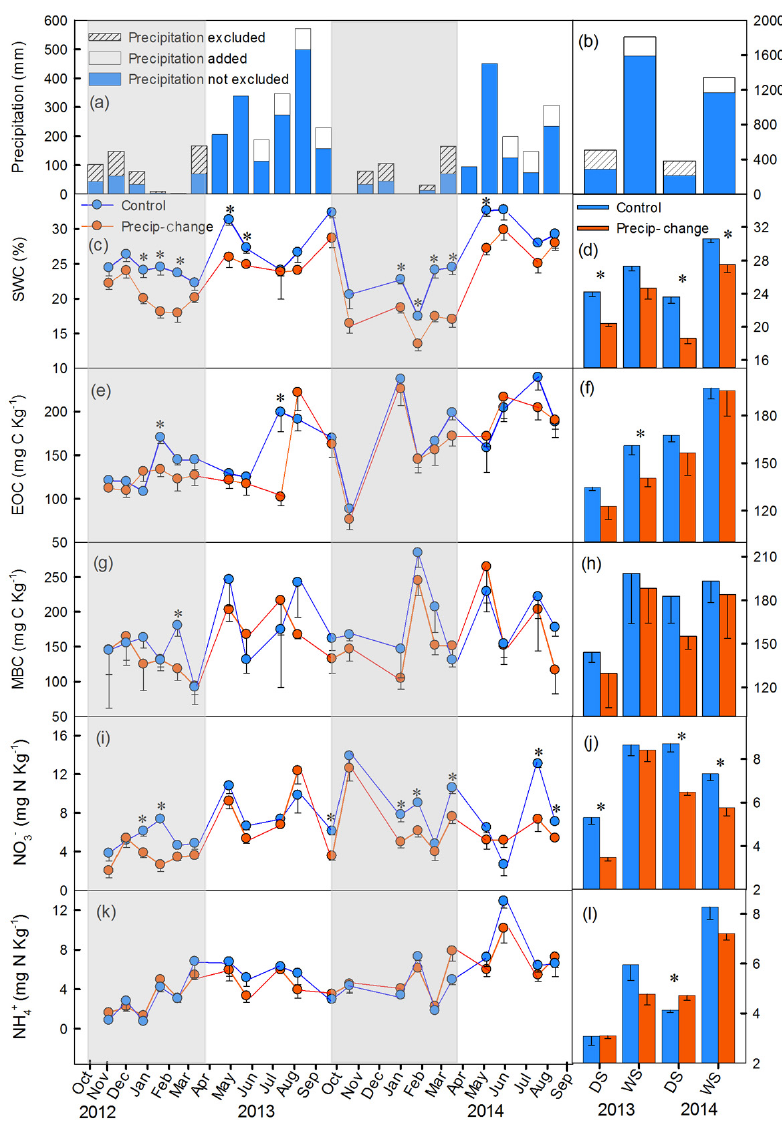
Figure 2. Seasonal dynamics of precipitation and soil physicochemical properties in control and precipitation change (precip-change) plots over the course of experiment. Points and bars with standard error ( n = 4) show mean values at each sampling time and in dry (DS) and wet (WS) seasons. Grey shades indicate the periods of precipitation reduction. The significance levels are presented as ∗ p < 0 .